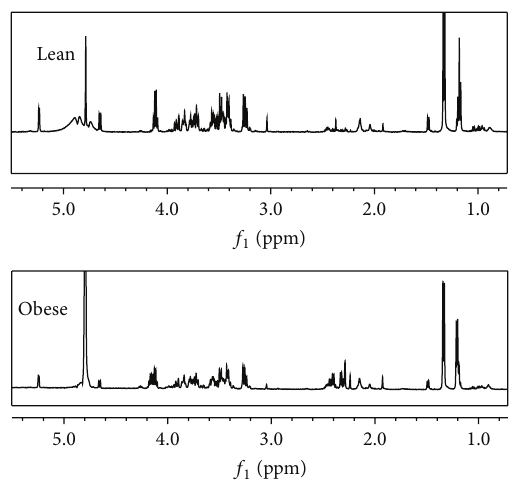
Figure 2: Typical 500 MHz 1 H NMR spectra of serum collected from a Sprague-Dawley rat fed a normal diet (lean) and a Sprague- Dawley rat fed a high fat diet (obese).